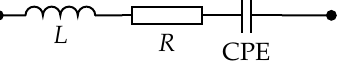
10 mH is parasitic ∼